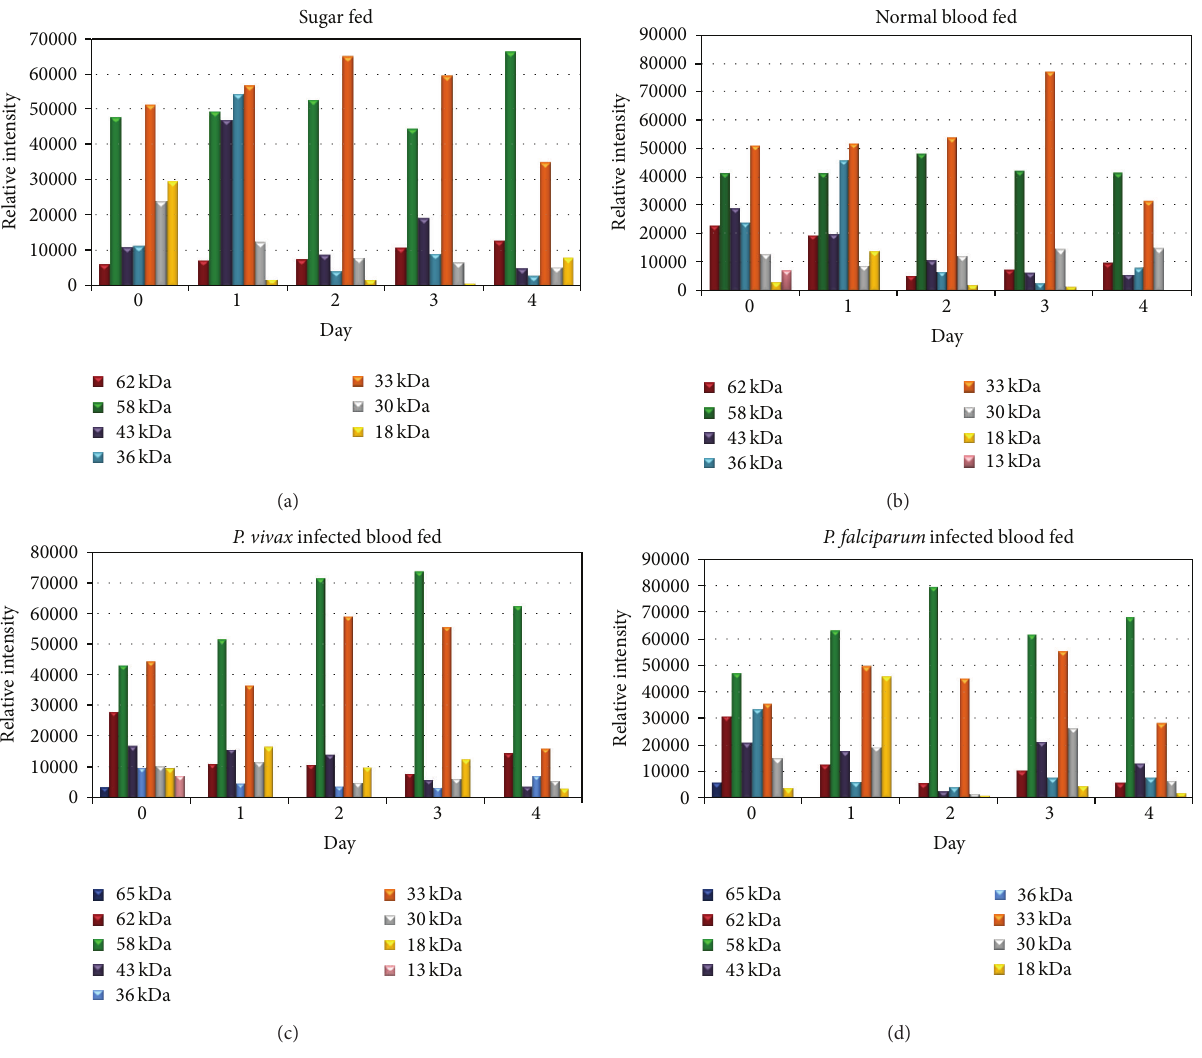
Figure 4: Relative profiles of the protein bands at 65, 62, 58, 43, 36, 33, 30 and 18kDa from sugar (a), normal blood (b), P. vivax infected blood (c), P. falciparum infected blood (d) fed female salivary glands An. dirus . The bar graph indicated the relative intensity after their infected blood feeding at days 0, 1, 2, 3 and